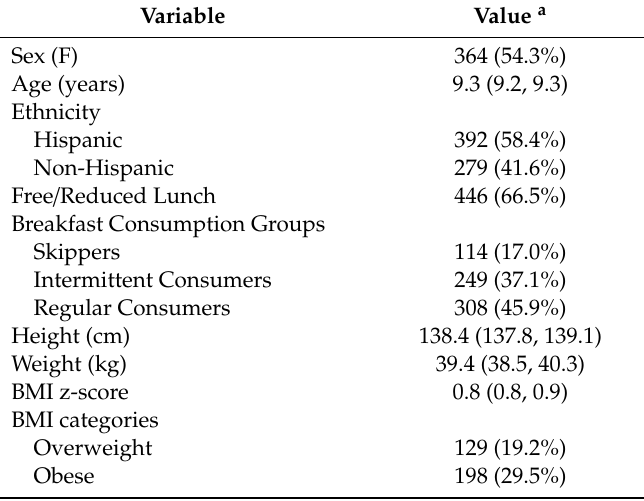
Table 1. Physical characteristics of the analytic sample ( n = 671).